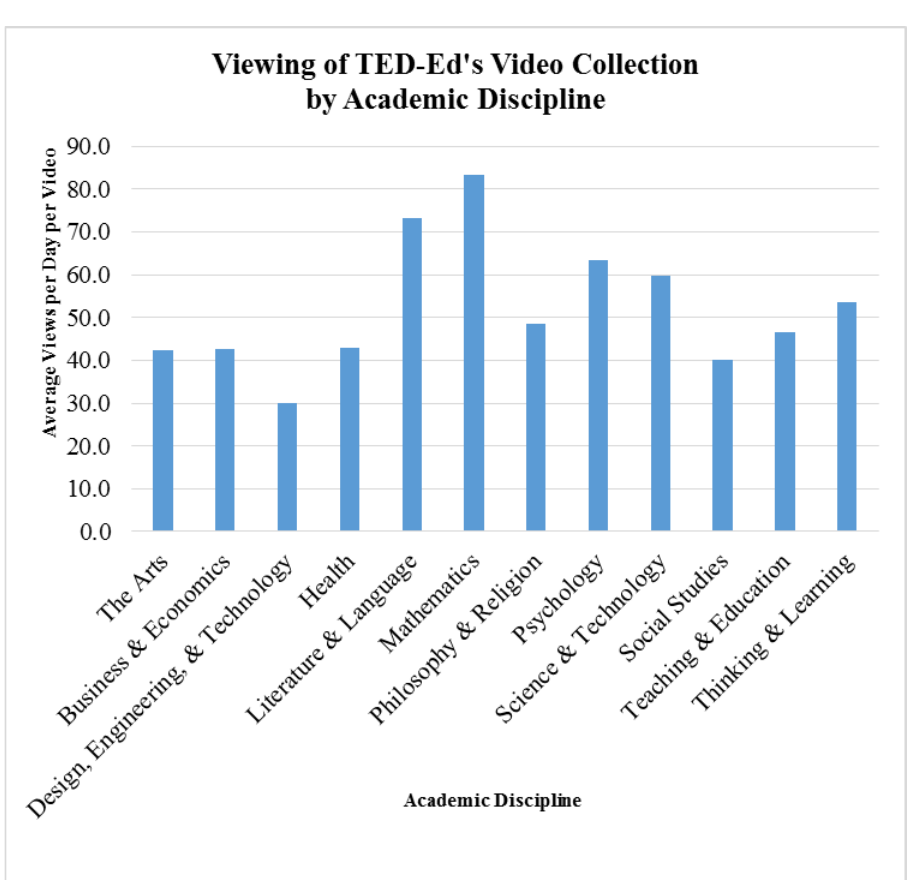
Figure 7 . Viewing by academic